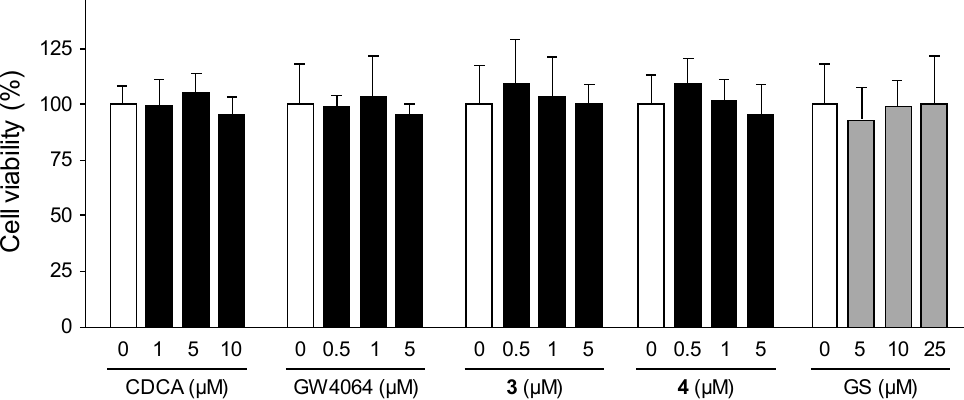
Figure 3. Cytotoxicity of FXR agonists and GS in ST-2 MSCs. The ST-2 MSCs (vehicle: V; white columns) were cultured for 12 days in the medium containing one of FXR agonists; 1–10 µ M CDCA, 0.5–5 µ M GW4064, 0.5–5 µ M of novel FXR agonists 3 or 4 (black columns), and 5–25 µ M GS (gray columns). Cell viability was measured by a WST assay. Data are shown as means ± S.D. from three